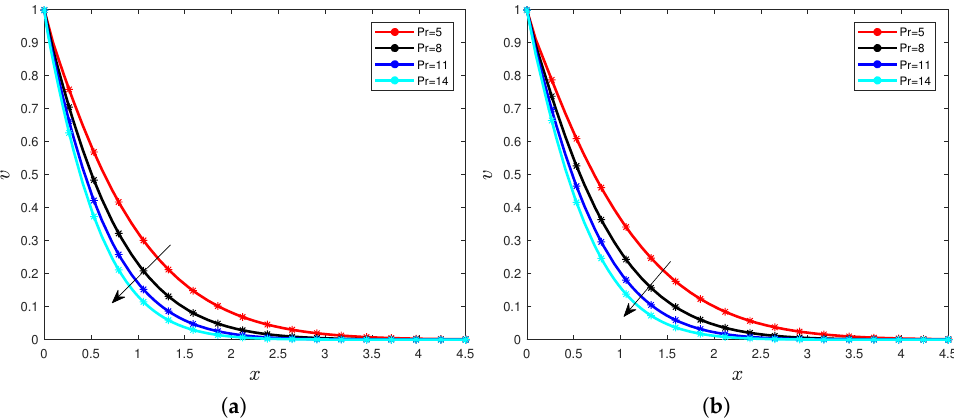
Figure 11. Temperature for different values of the Prandtl number with α = 0.65 ( a ) and α = 0.75 ( b